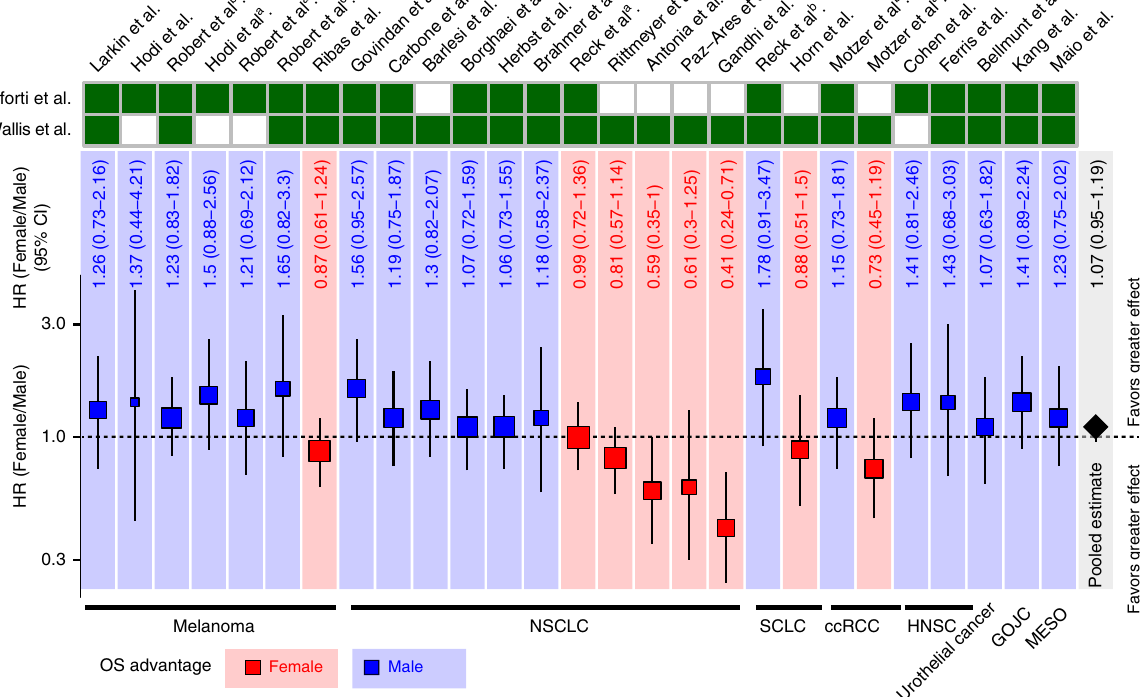
Fig. 1 Clinical outcomes between male and female patients with ICB treatment. The interaction between ICB treatment ef fi cacy and gender for clinical trials summarized in Supplementary Fig. 1. Background and square color indicate OS advantage of ICB treatment in female (red) or male (blue). Square size indicates the proportion to the inverse of the variance of the estimates. Black vertical lines indicate the 95% con fi dence interval (CI). Cells fi lled with dark green indicates the data set used in this meta-analysis. Sample size for each trial was listed in Supplementary Table 1. a,b,c Indicate the different studies from the same fi rst author and published in the same years. ccRCC clear cell renal cell carcinoma, GEJC gastric or gastroesophageal junction carcinoma, HNSC head and neck cancer, NSCLC non-small-cell lung cancer, SCLC, small-cell lung cancer, MESO